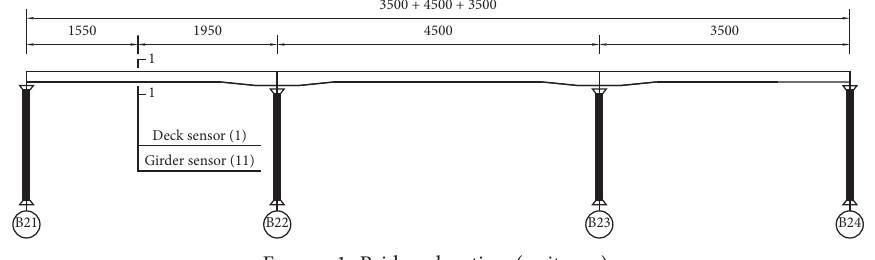
Figure 1: Bridge elevation (unit: cm).